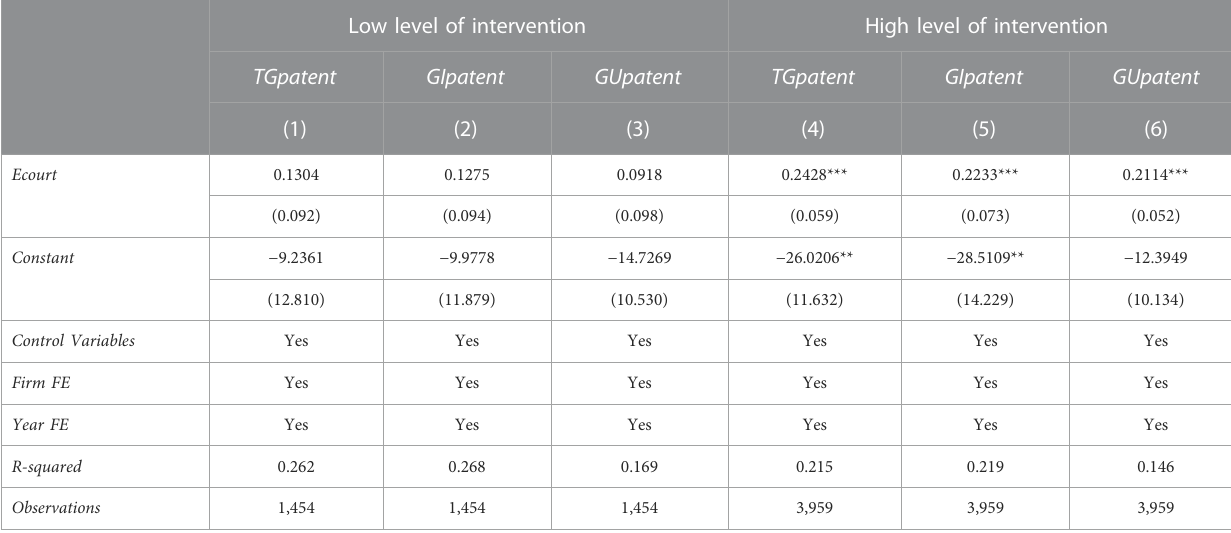
TABLE 8 Local government intervention. Low level of intervention High level of